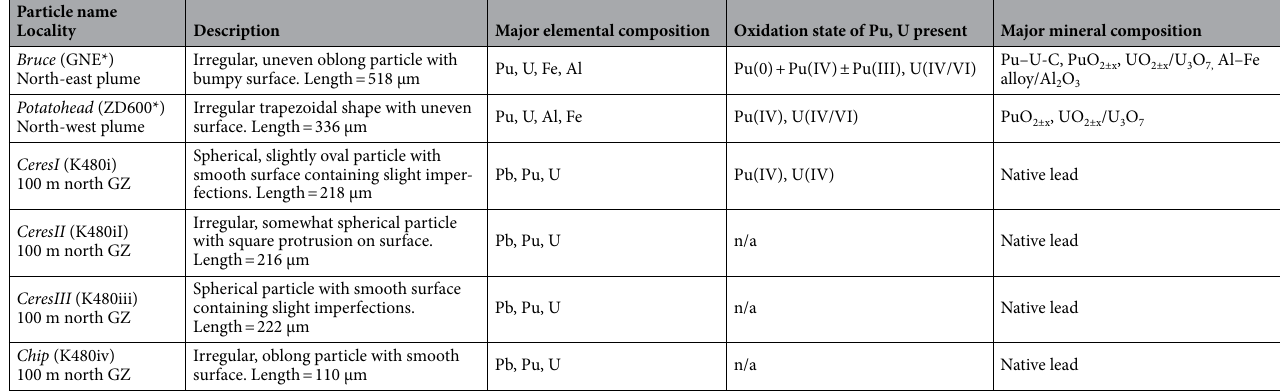
Table 1. Summary of hot particle characterization results using µ-SXRF, µ-XAS, and µ-XRD techniques. *Particles from study of Burns and co-workers 5,7